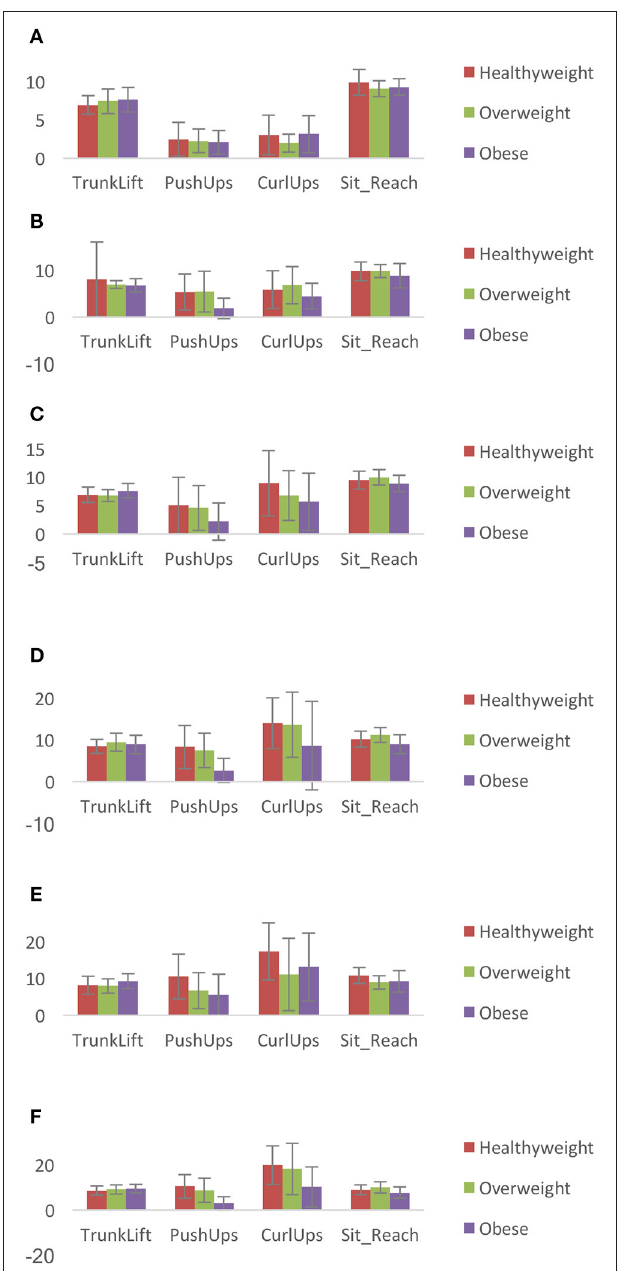
FIGURE 1 | Mean (SD) musculoskeletal fitness scores in: (A) kindergarten, (B) 1st grade, (C) 2nd grade, (D) 3rd grade, (E) 4th grade, and (F) 5th grade. Scores on trunk lift and the back saver sit and reach tests were measured in inches, while push-up and curl-up are the number of repetitions completed.